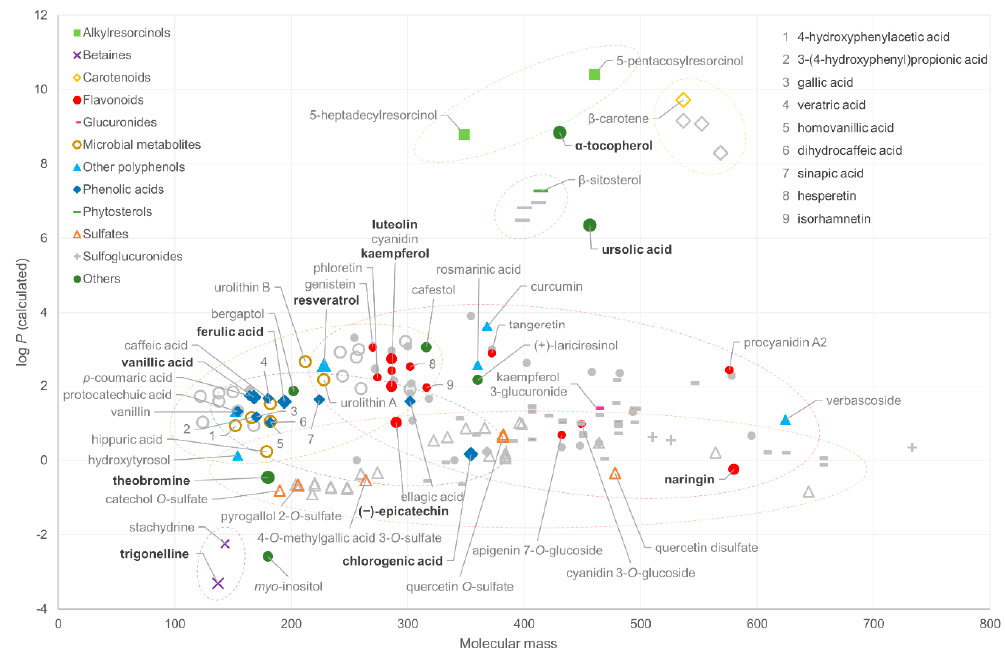
Figure 1. The chemical space (calculated log P as a function of monoisotopic molecular mass, MM) of the reference standards included in the analysis (colored markers), included in the initial list (including grey markers) and included in the proposed analytical coverage quality control mixture (highlighted compounds with bold text).